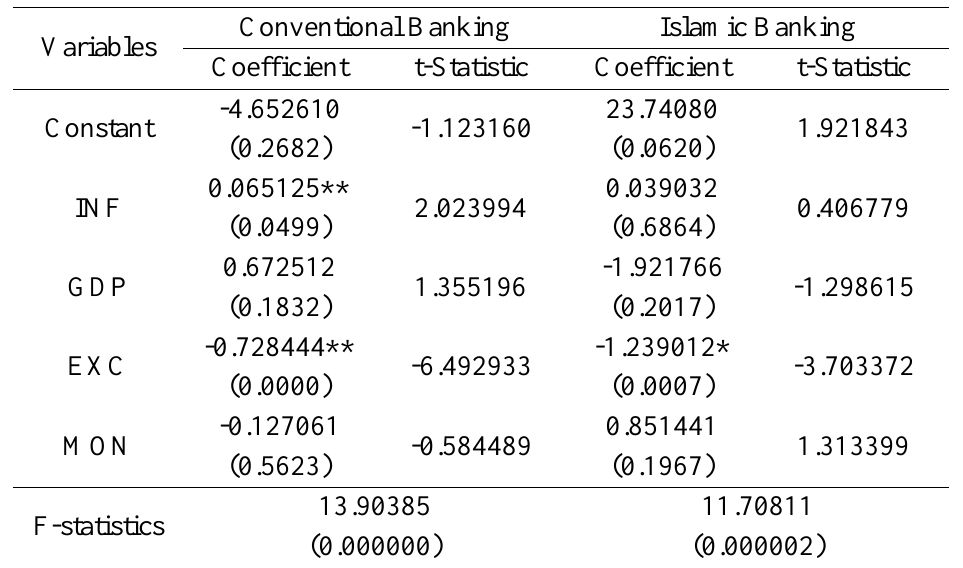
Table 5. Long-Term